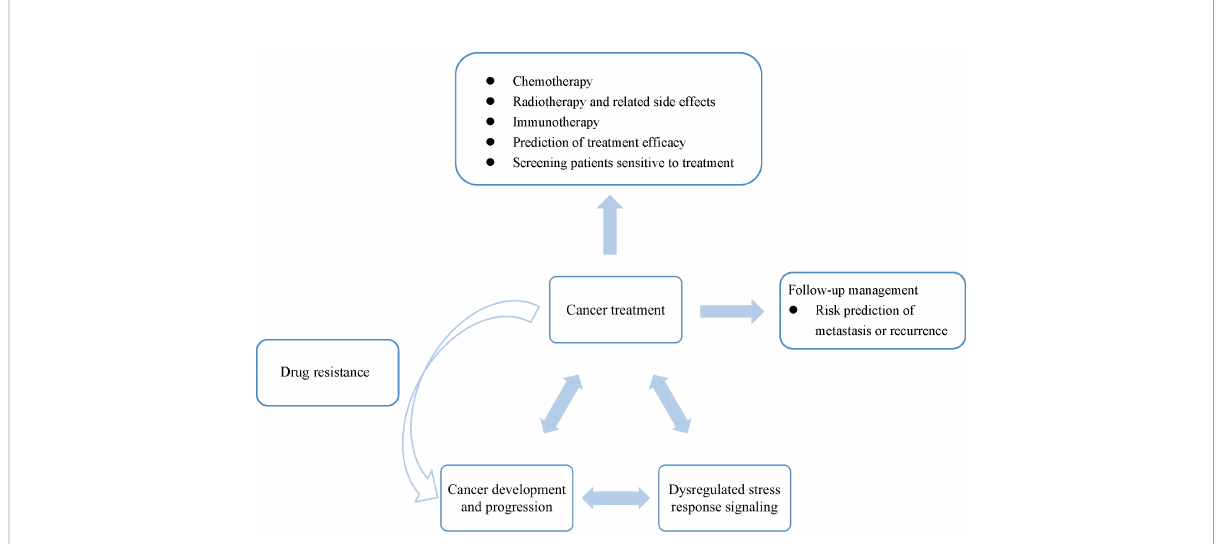
FIGURE 1 Understanding the interaction among dysregulated stress response, cancer development and progression, and cancer treatment bene fi ts cancer diagnosis, therapeutics development, and post-treatment